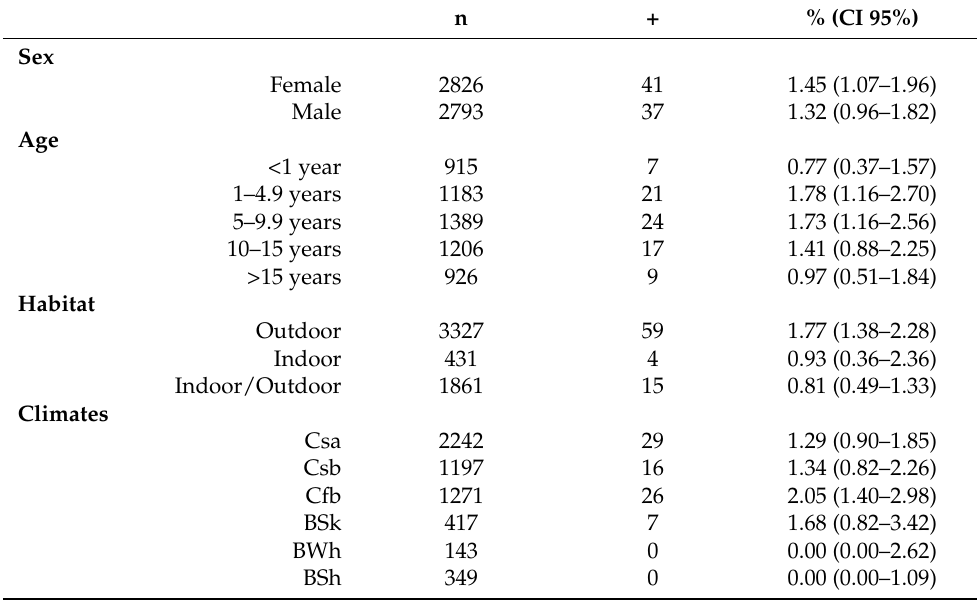
Table 3. Prevalence of A. vasorum in dogs in Spain by sex, age, habitat, and climate. Abbreviations: n, number of dogs sampled; +, number of positive dogs; %, percentage of positive dogs (confidence interval 95%); BSh: hot semi-arid climate (steppe); BSk: cold steppe climate; BWh: desert climate; BWk: Cold desert climate; Cfb: oceanic climate; Csa: hot-summer Mediterranean climate; Csb: warm-summer Mediterranean climate.